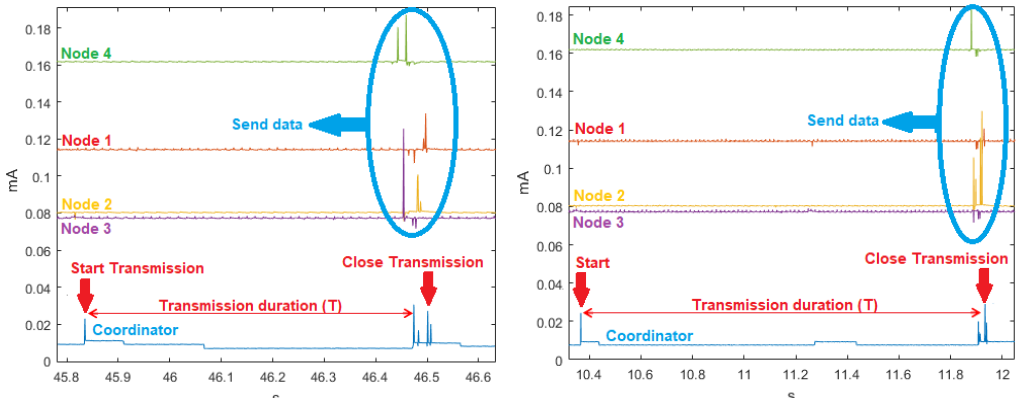
Figure A1. Detailed time signals for DigiMesh network at 9600 bauds in two example realizations: ( Left ) Realization 4; and ( Right ) Realization 5.